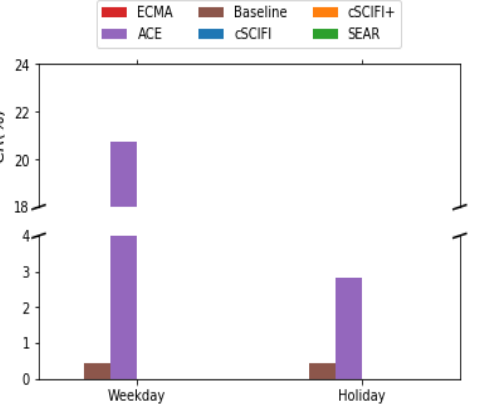
Figure 8. Coverage ratio loss comparison between a holiday and a